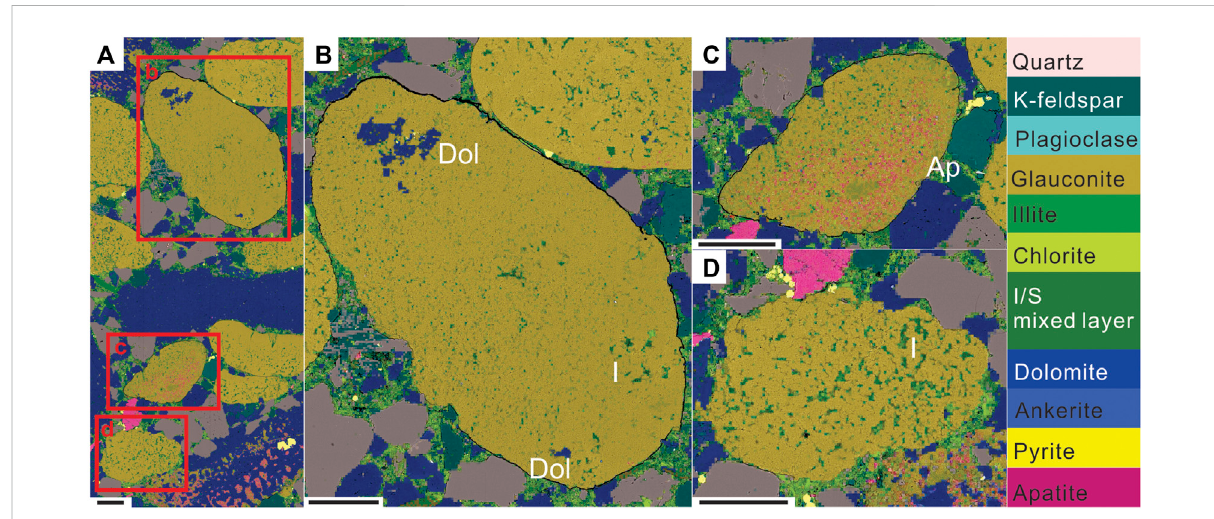
FIGURE 12 Representative petrographic images of glauconite-bearing, dolomitized sandstones from the lower Cambrian Tempe Formation in the Amadeus Basin for in situ Rb-Sr dating. Scale bars represent 100 μ m. (A) A 1.8 × 0.8 mm overview image of sample H41; (B) glauconite grains with dolomite and illite inclusions; (C) glauconite grain with apatite and illite inclusions; (D) glauconite grain with illite inclusions. The mineral mapping visualize impurities of the targeted mineral, which can guide the sample selection for Rb-Sr dating and inform the data